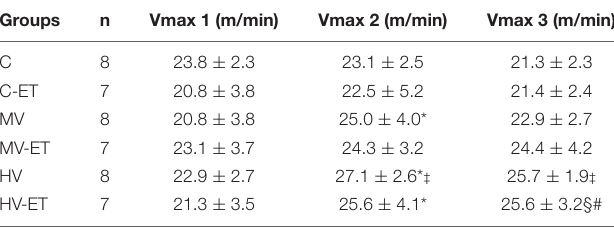
TABLE 2 | Maximum velocity